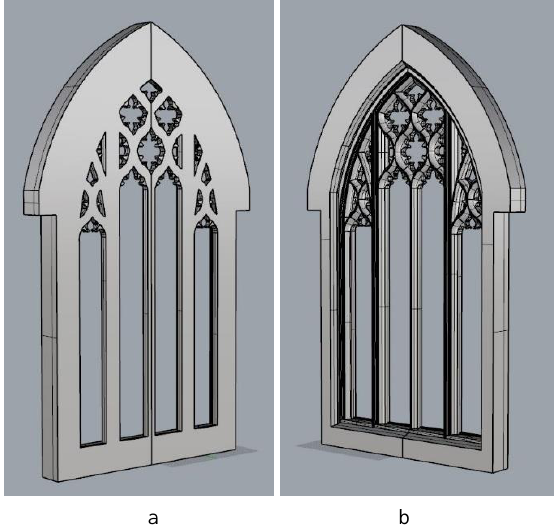
Figure 1: a) Simplified plane of model. b) Model showing Gothic tracery.